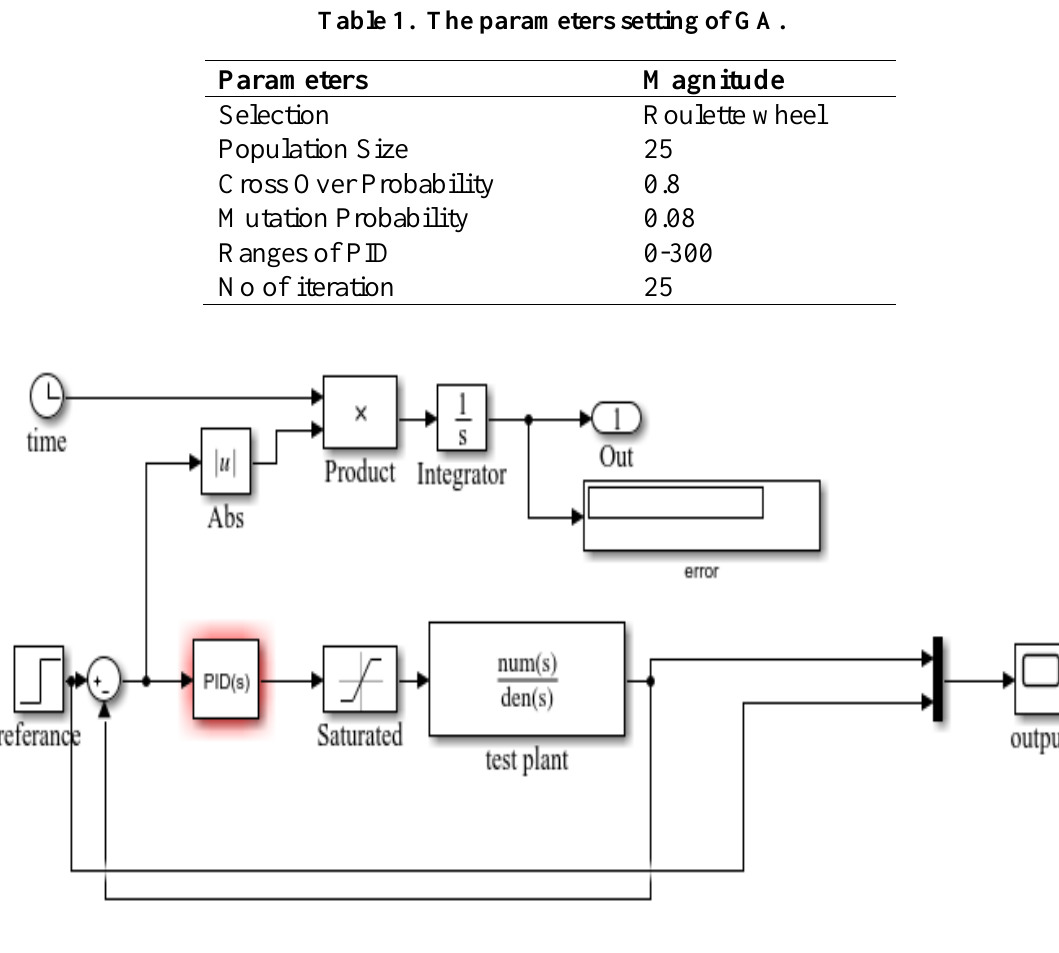
Fig. 5. Simulink model of a system with